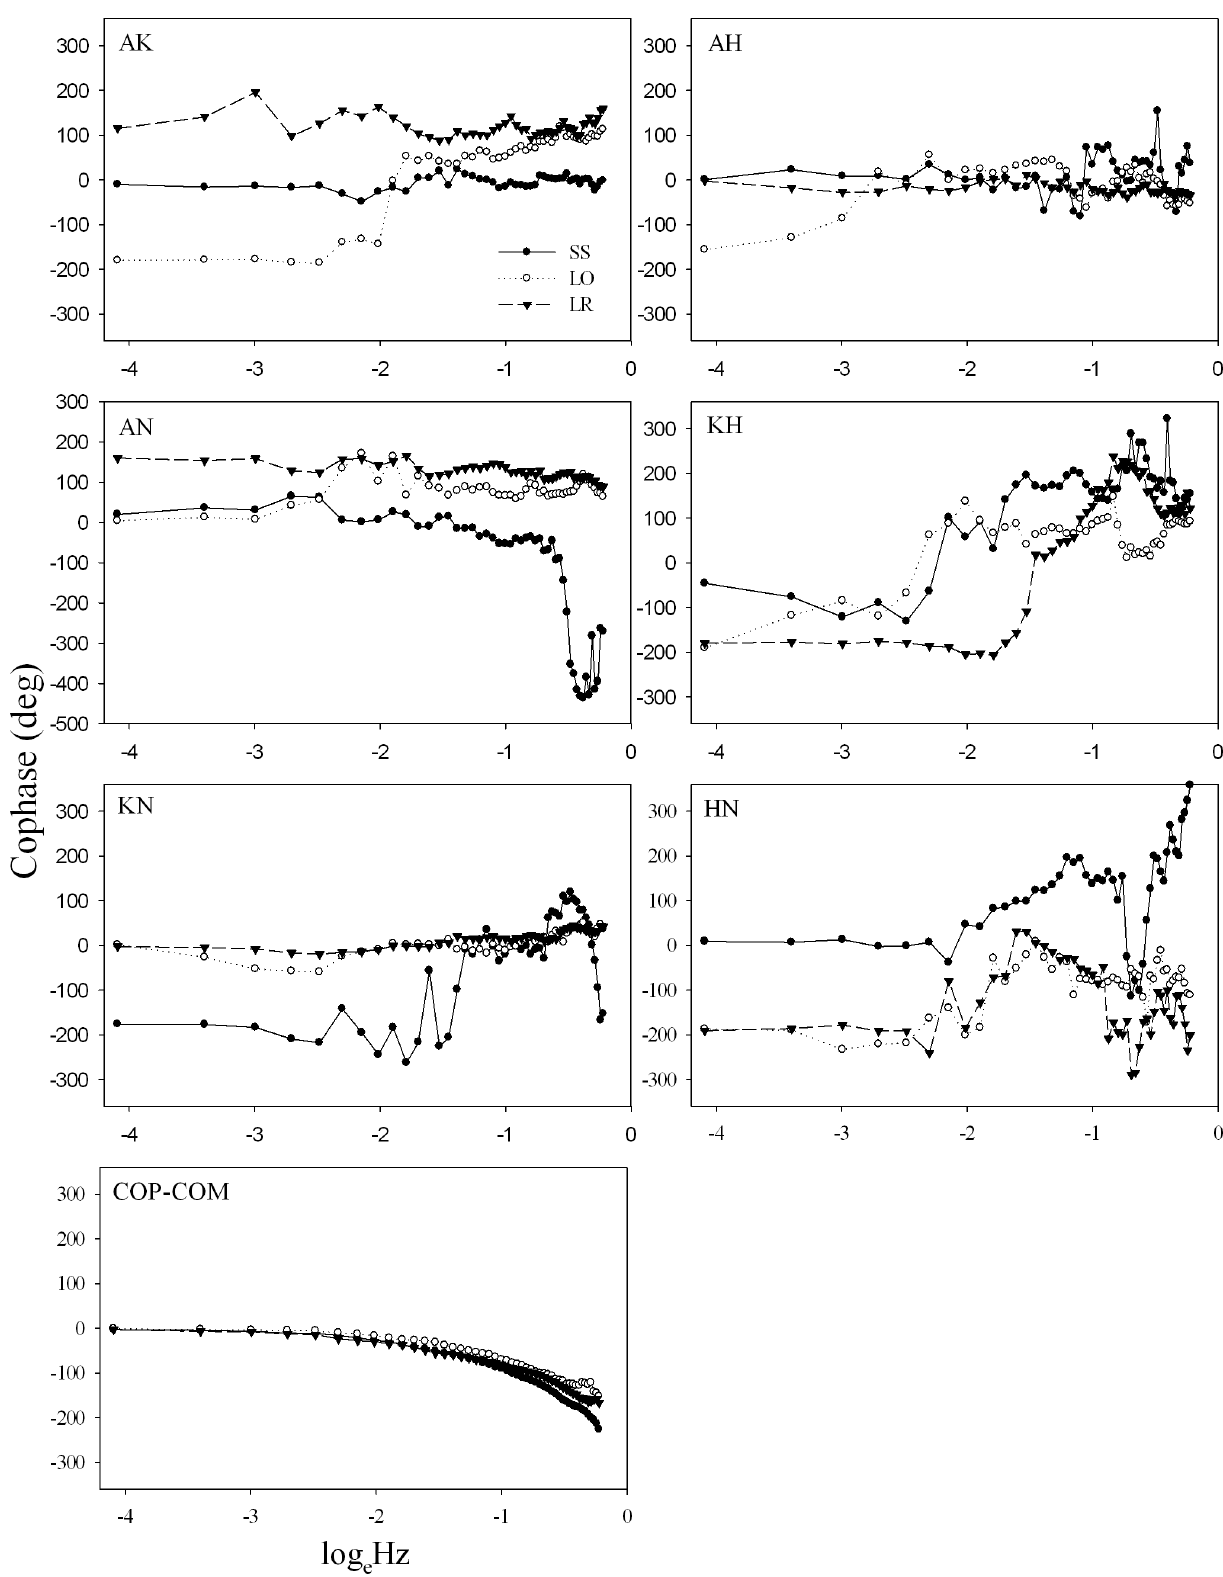
Figure 4. Cophase (group mean) of all pairs of joint synergies and COP-COM coupling at different standing conditions. Anatomical abbreviations are as in Fig. 2.